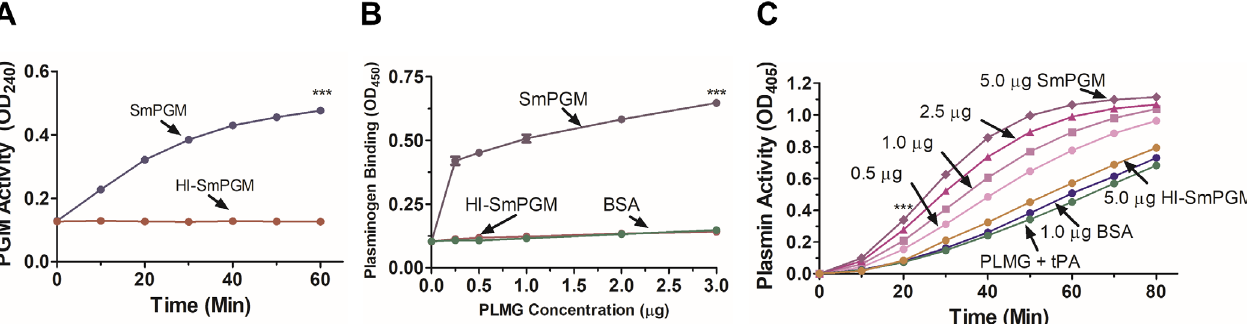
Figure 6. rSmPGM binds to plasminogen and promotes plasmin generation. (A) SmPGM activity of heat-inactivated SmPGM (HI-SmPGM, red line) compared to non-heat-treated SmPGM (blue line) *** p < 0.001 (two-way ANOVA with Bonferroni post-test). (B) Plasminogen (PLMG, at increasing concentration) binding to puri fi ed rSmPGM (0.5 l g, purple line) versus heat-inactivated rSmPGM (HI-SmPGM, 5.0 l g, red line) or control protein (BSA, 0.5 l g, green line) detected by ELISA. Signi fi cant differences between PLMG binding to rSmPGM versus heat-inactivated (HI) rSmPGM or BSA at all concentrations of PLMG are denoted by *** p < 0.001 (two-way ANOVA with Bonferroni post- test). (C) Plasmin activity detected in the presence of tPA and PLMG alone (green line) or supplemented with increasing amounts of puri fi ed SmPGM (0.5 – 5.0 l g, as indicated) or BSA (1.0 l g, blue line) or HI-SmPGM (5.0 l g, orange line) over time. Signi fi cant differences at all time points beyond 20 min compared to controls are denoted by *** p < 0.001 (two-way ANOVA with Bonferroni